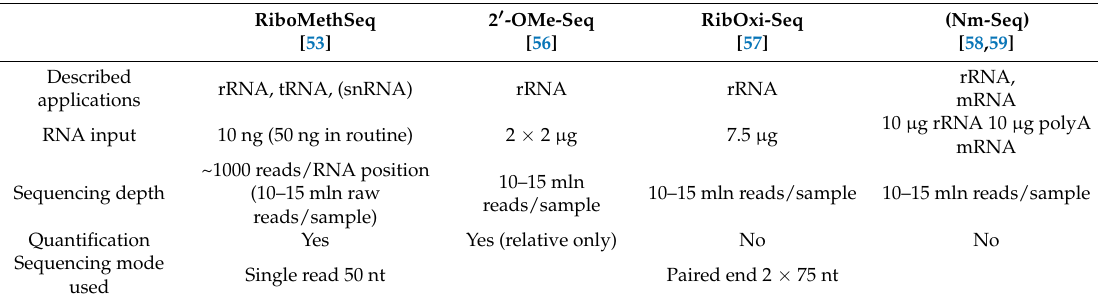
Table 1. Comparison of published deep sequencing–based methods for 2 (cid:48) - O -Me detection. RiboMethSeq